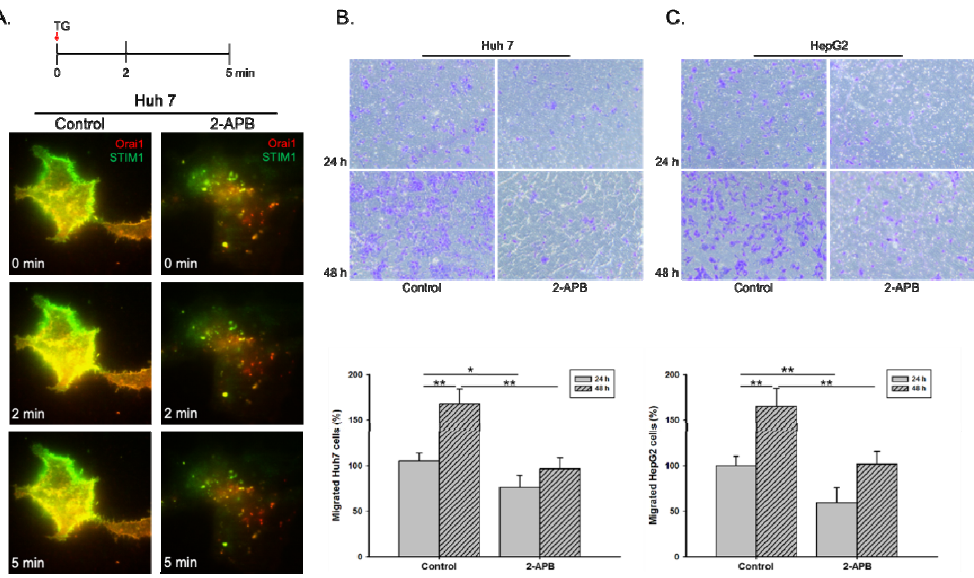
Figure 2. Inhibition of STIM1-ORAI1 colocalization by 2-APB pre-treatment leads to reduced liver